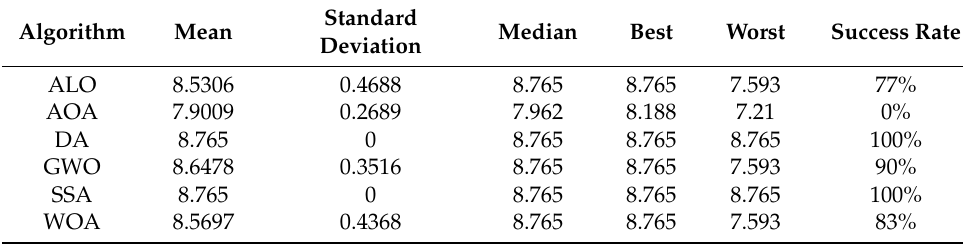
Table 1. Statistical summary of 10 trials in optimizing MRR .